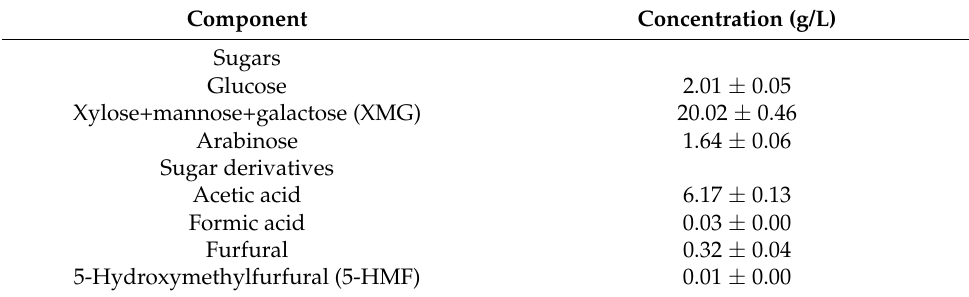
Table 1. Chemical composition of dilute acid hydrolysate of Quercus mongolica